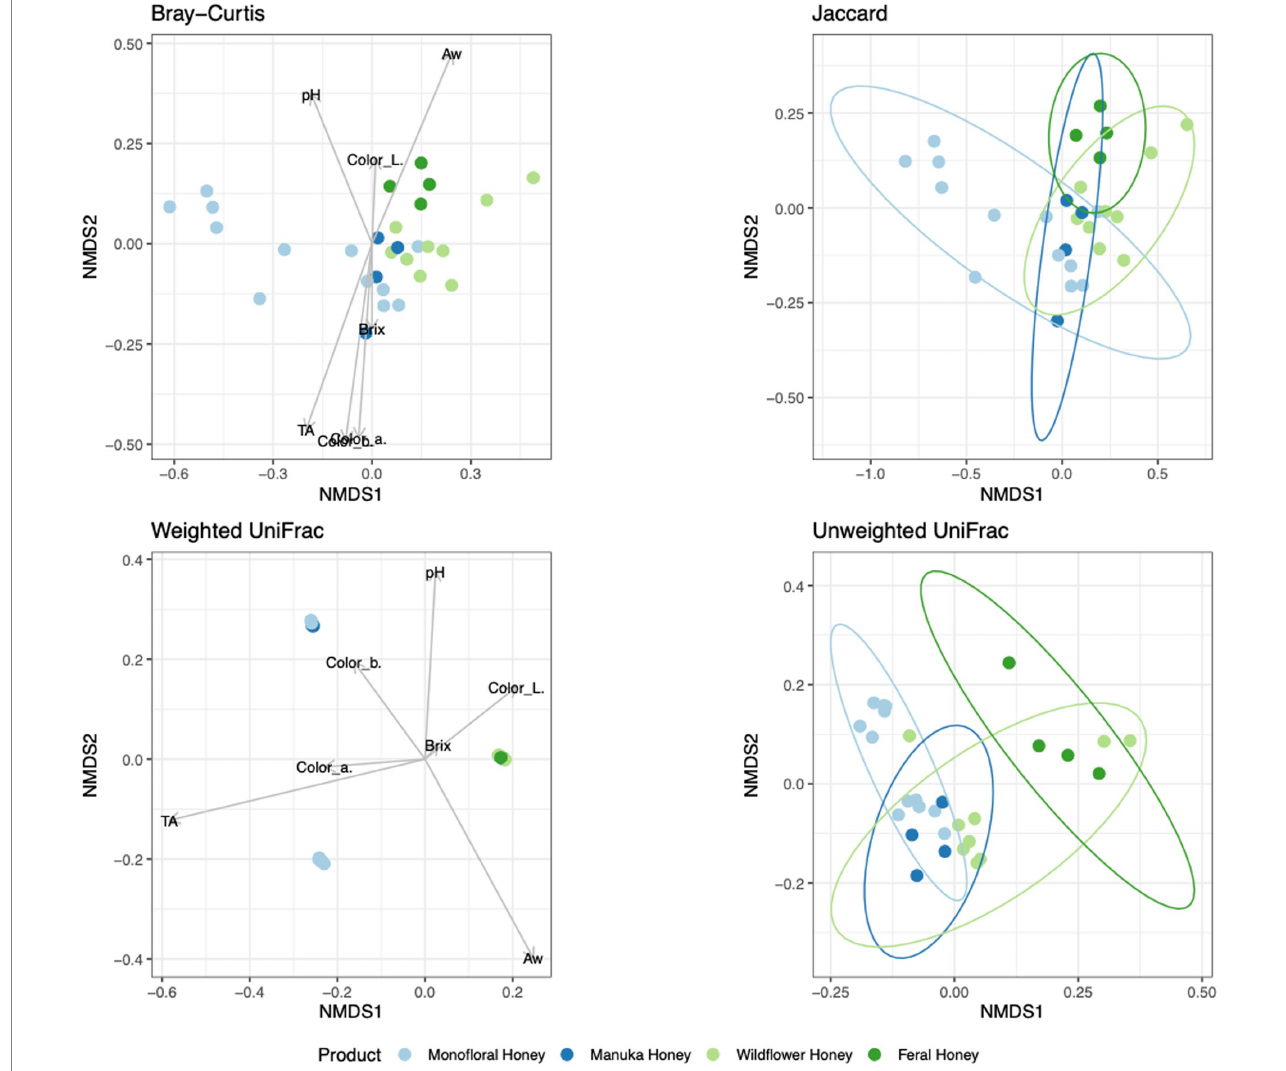
FIGURE 7 Non-metric multidimensional scaling (NMDS) ordination for bacterial community structure based on the relative abundance of 16S ASVs. Community dissimilarity was evaluated with four metrics: Bray–Curtis, Jaccard, weighted UniFrac, and unweighted UniFrac. Arrowed lines (vectors) showing correlation between physicochemical properties and community dissimilarity were plotted for Bray–Curtis and weighted UniFrac metrics. The vectors represented mean direction and strength of correlation. Ellipses indicating confidence intervals of 95% for all honey types were plotted for Jaccard and unweighted UniFrac